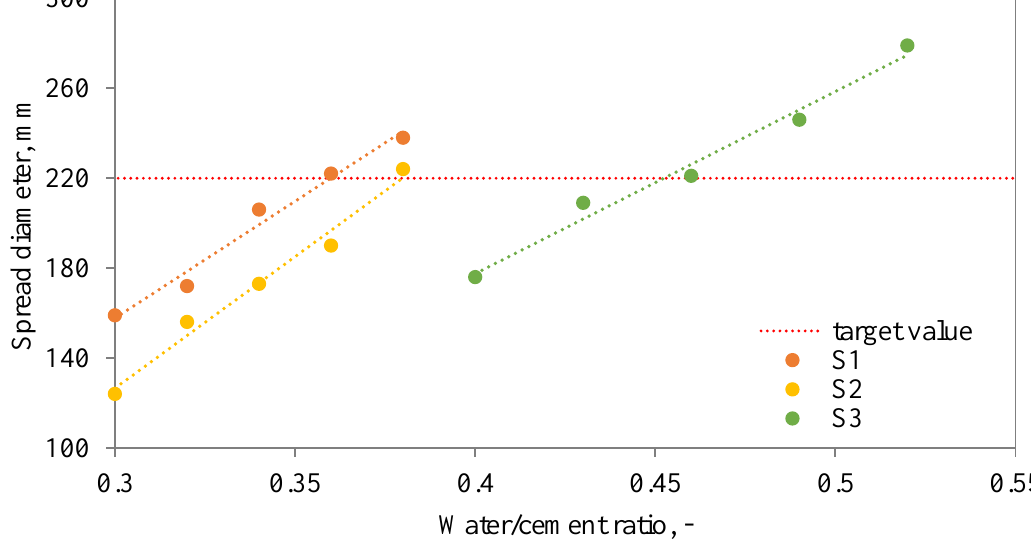
Figure 6. Dependency between spread diameter and additional water dosage for H mixtures.